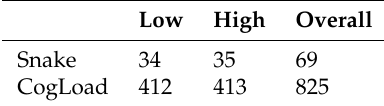
Table 7. Number of instances in the ML experiments for the two